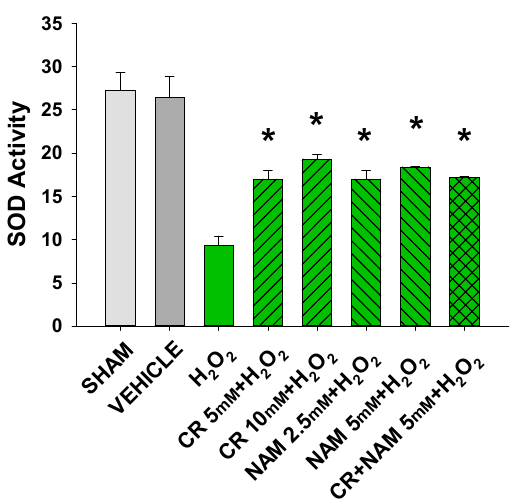
Figure 9. Effect of Cr and NAM pretreatment on SOD activity. DHF cells were exposed to various concentrations of Cr or NAM alone or combined, media alone (SHAM), or water vehicle (1%). Twenty-four hours later, the cells were exposed to 600 µM H 2 O 2 for 30 min. SOD Assay kit-WST (Dojindo) was used measure SOD activity at that time. The data are mean ± SE from duplicate experiments using triplicate samples. * Denotes statistically significant changes in the Cr/NAM treated levels in comparison to H 2 O 2 alone.